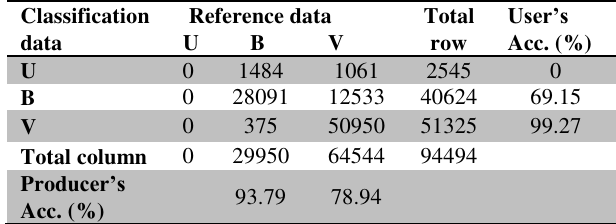
Table 8. Confusion matrix of labelled point based on NDFI NIR- MIR in Site